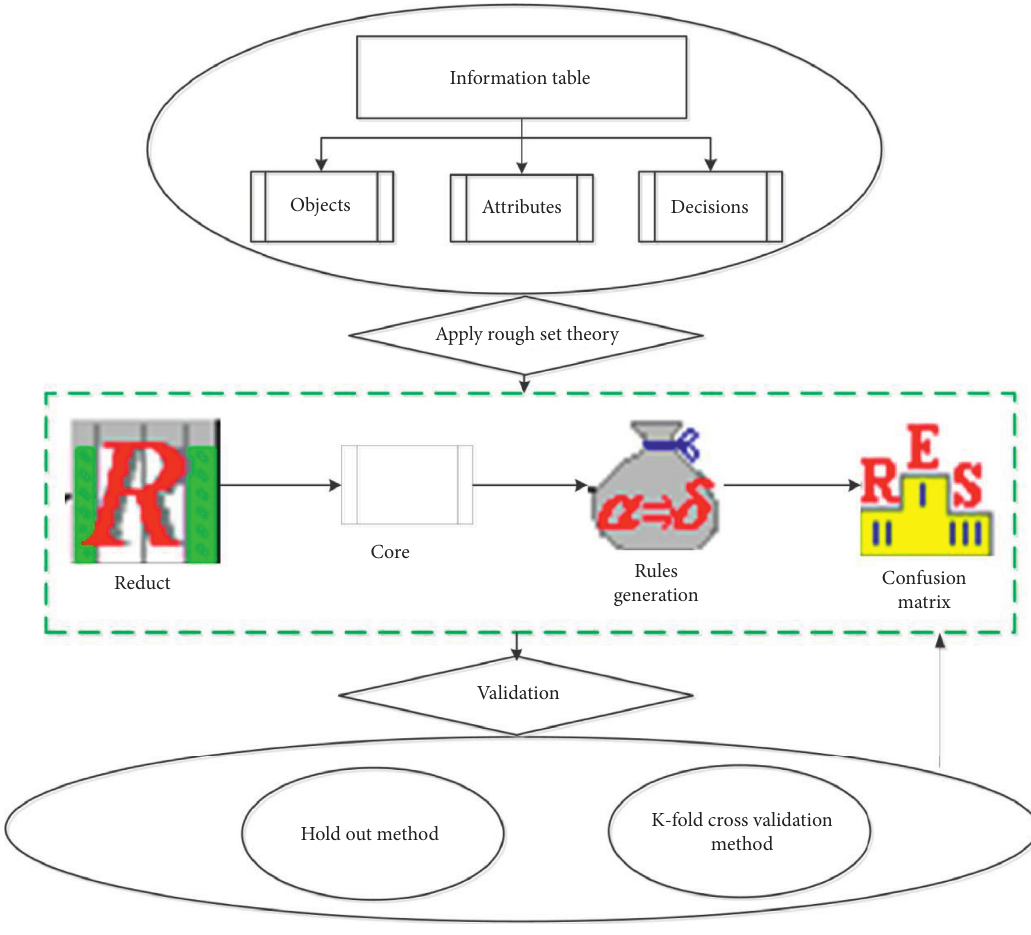
Figure 2: Generic rough set process.